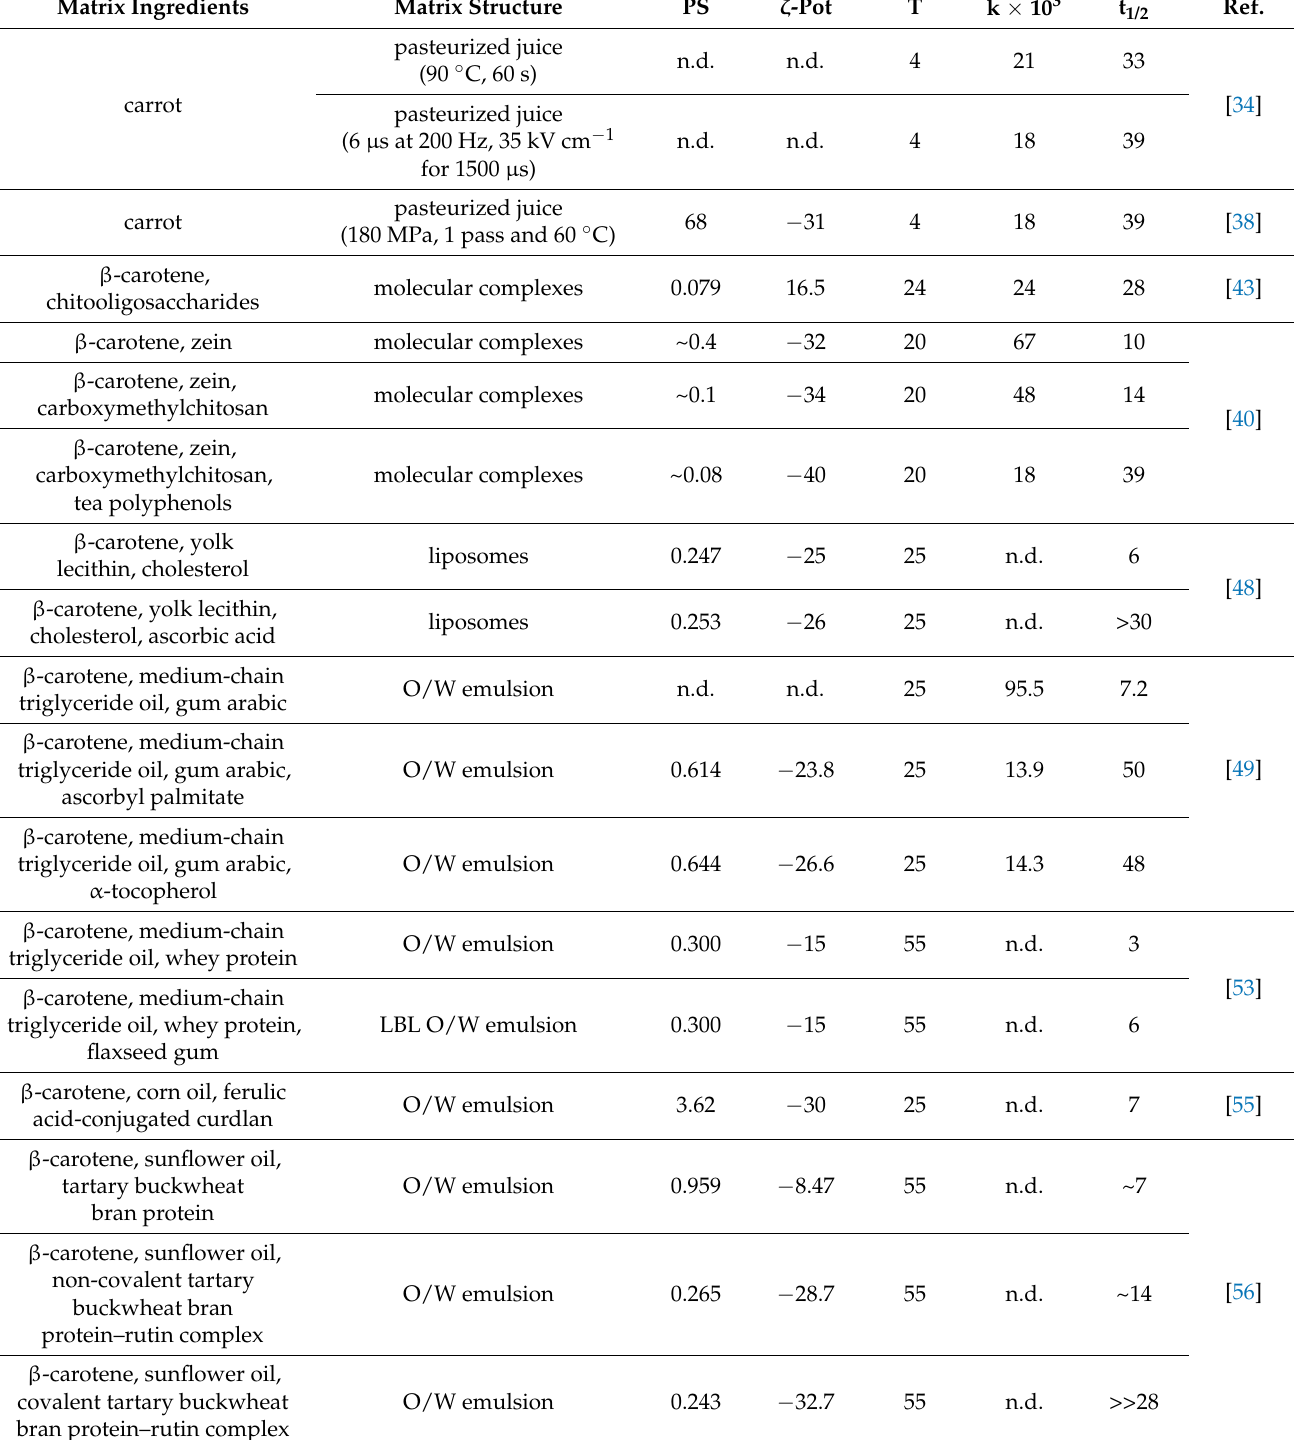
Table 1. Encapsulation systems systems for the delivery of β -carotene in aqueous environments: matrix ingredient and structure, particle size (PS, µ m), ζ -potential ( ζ -pot, mV), first-order